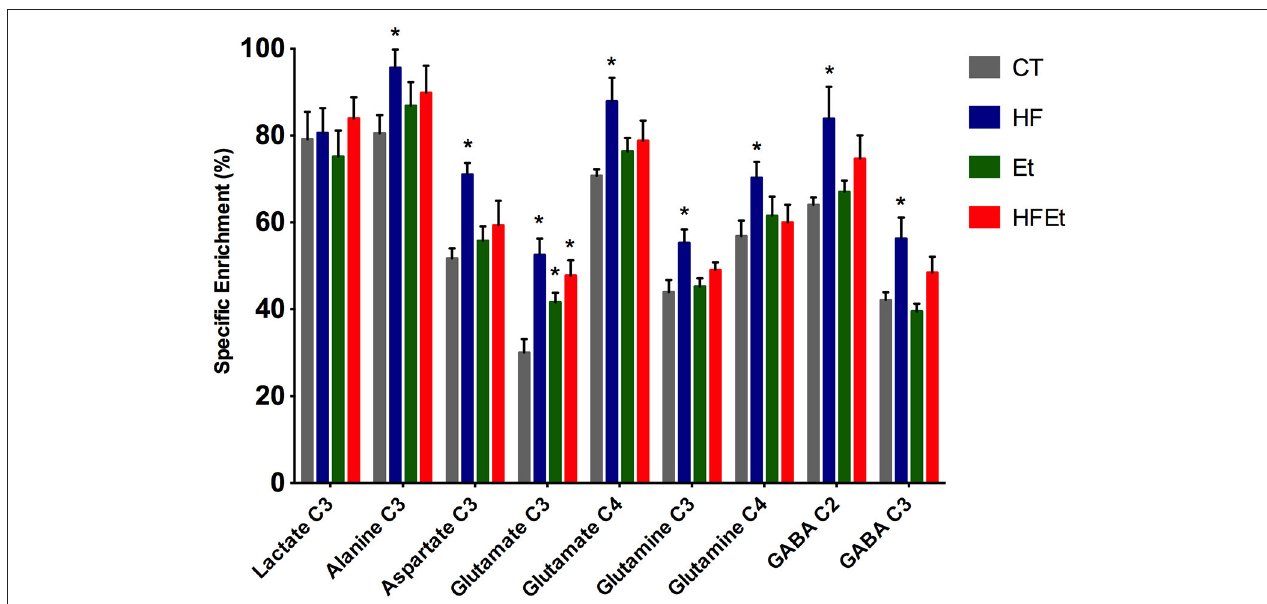
FIGURE 5 | 13 C-specific enrichments (%) of some carbon positions of some brain metabolites after 1h infusion of [1- 13 C]glucose in rats fed with control (CT), high fructose (HF), ethanol (Et) or mixed (HFEt) diet. *Statistical difference between CT and